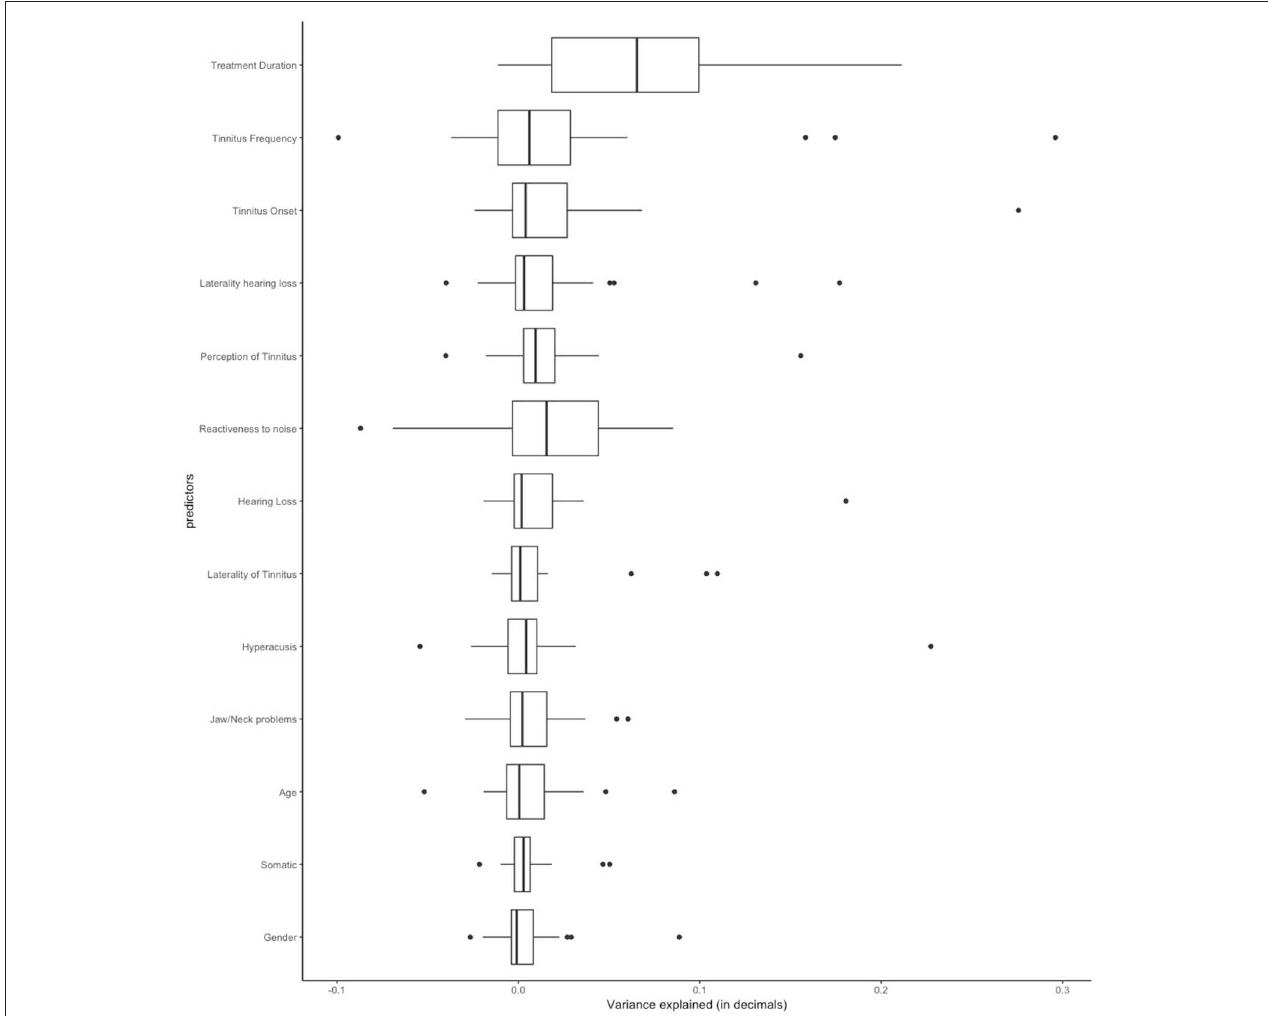
FIGURE 1 | Amount of variance explained in the linear regression models by each predictor across all different 25 treatments.